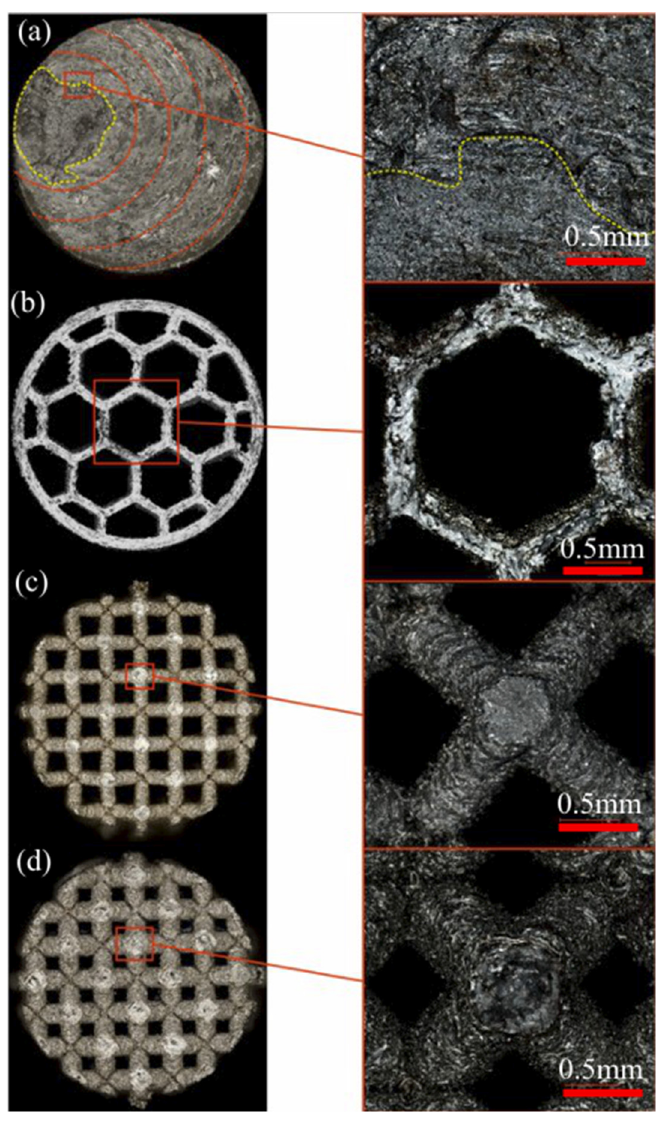
Figure 20. Images of breakthroughs: ( a ) monolithic sample, ( b ) honeycomb structure sample, ( c ) “Kagome” structure sample with 0.6 mm cell diameter and ( d ) “Kagome” structure sample with 0.8 mm cell diameter.